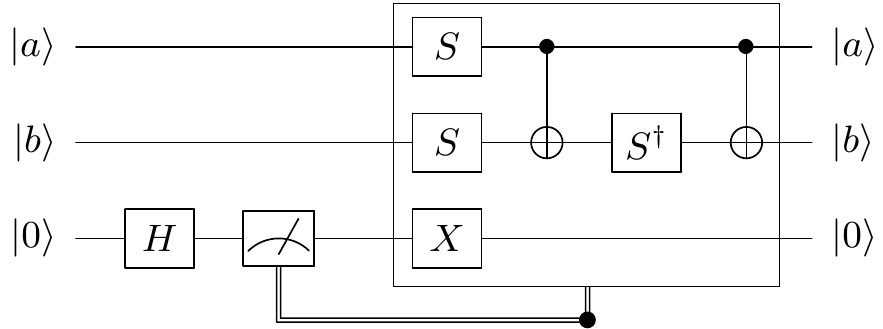
Figure 5. Quantum AND dagger Fig. 2: Quantum AND gate of T -depth one introduced in [5]